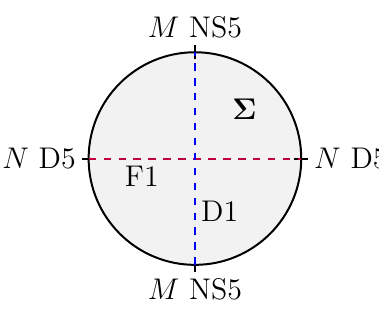
Figure 9. Disc representation of the solution with residues given in (4.18) along with the embed- dings of a D1-brane and a fundamental